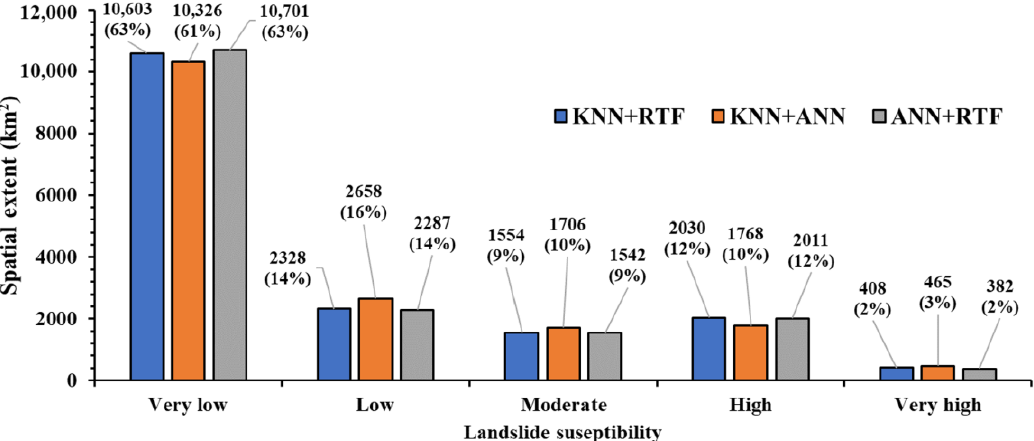
Figure 14. Landslide susceptibility statistics were derived using top-performing ensemble ML models using the top 5 LIFs.